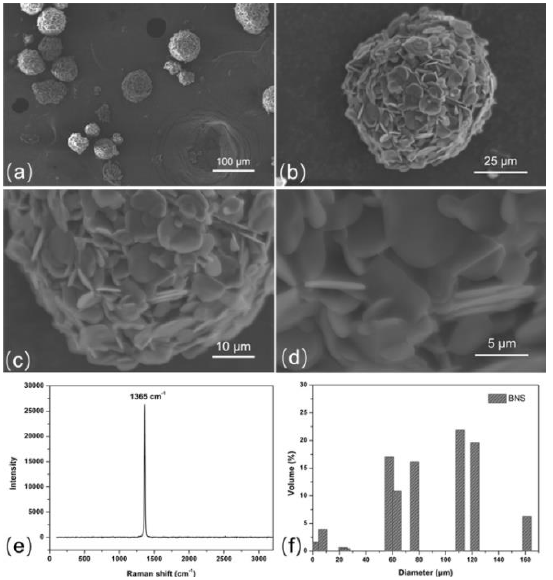
Figure 1. ( a – d ) SEM images, ( e ) Raman spectra, ( f ) particle size distribution of the BNS powder.